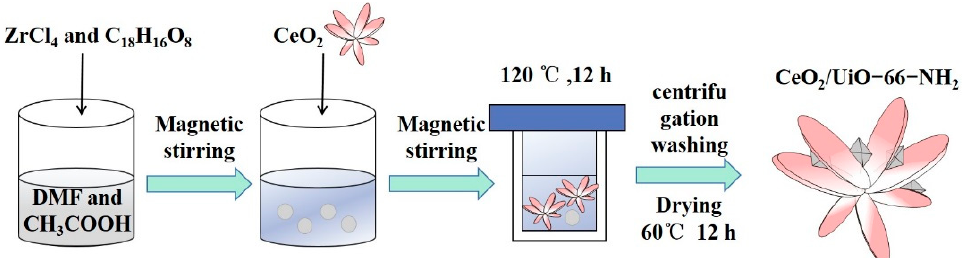
Figure 2. Diagrammatic sketch of the synthesis of Ce/UN composites.